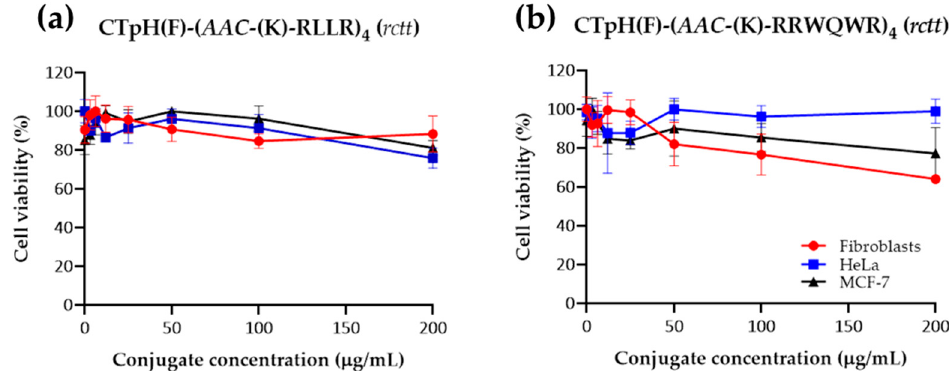
Figure 7. Cytotoxic activity on fibroblasts and MCF-7 and HeLa lines of the peptide-resorcinarene dendrimers obtained.